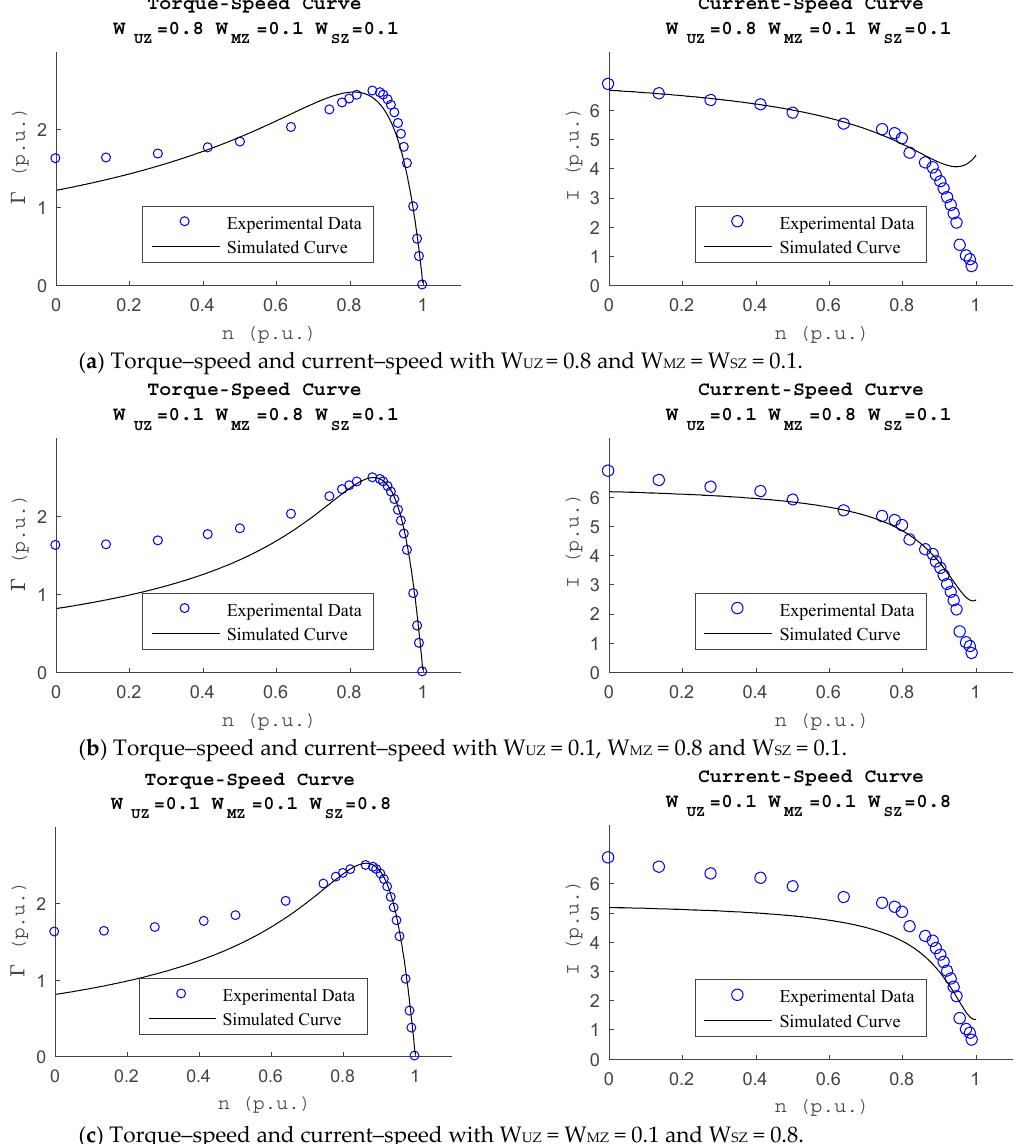
Figure 10. Torque–speed and current–speed curves with di ff erent operating zone weights. All cases with W T = W I =